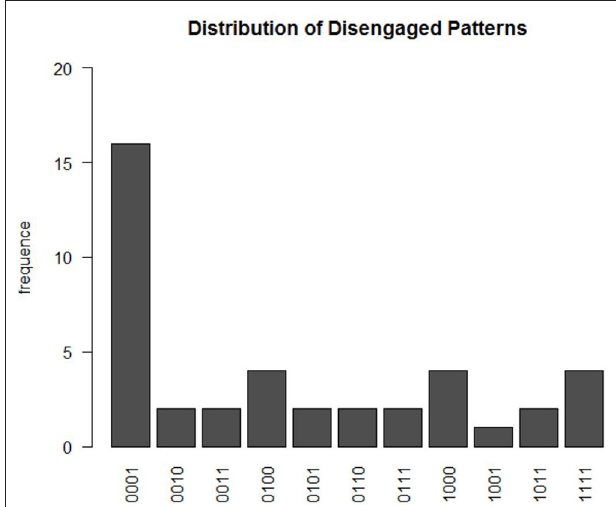
FIGURE 5 | The distribution of disengagement patterns. The x-axis represents the estimated summary pattern of D i , t s at four time points, with 1 indicating disengaged and 0 as engaged.